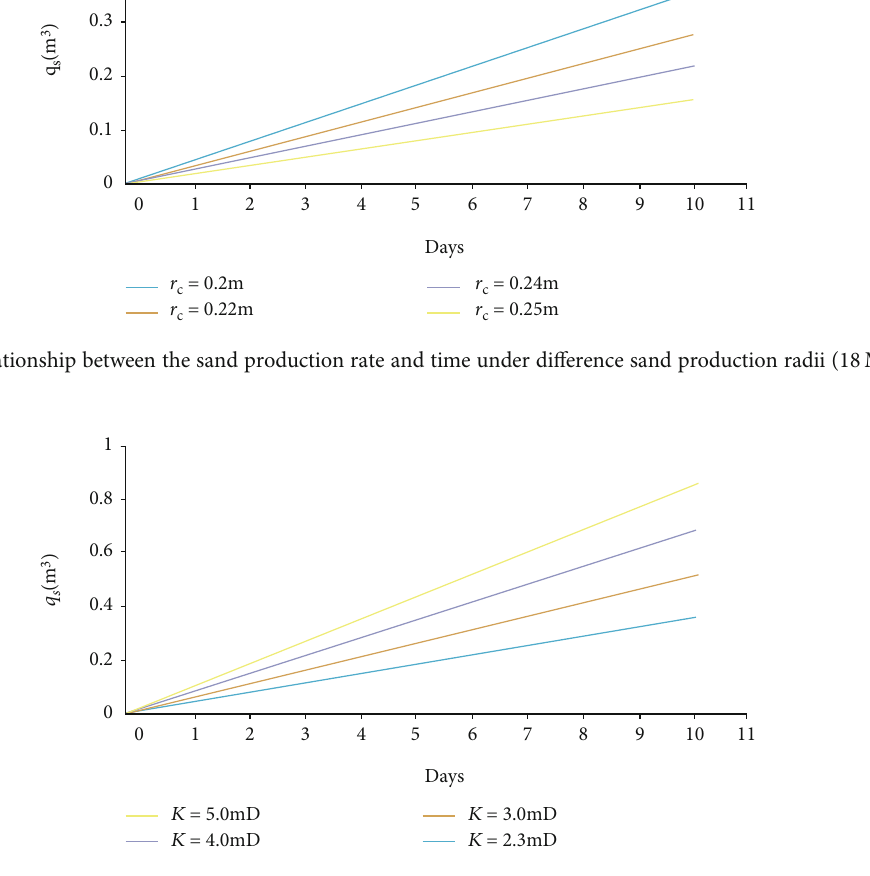
Figure 6: Relationship between the sand production rate and time under di ff erent permeabilities (18